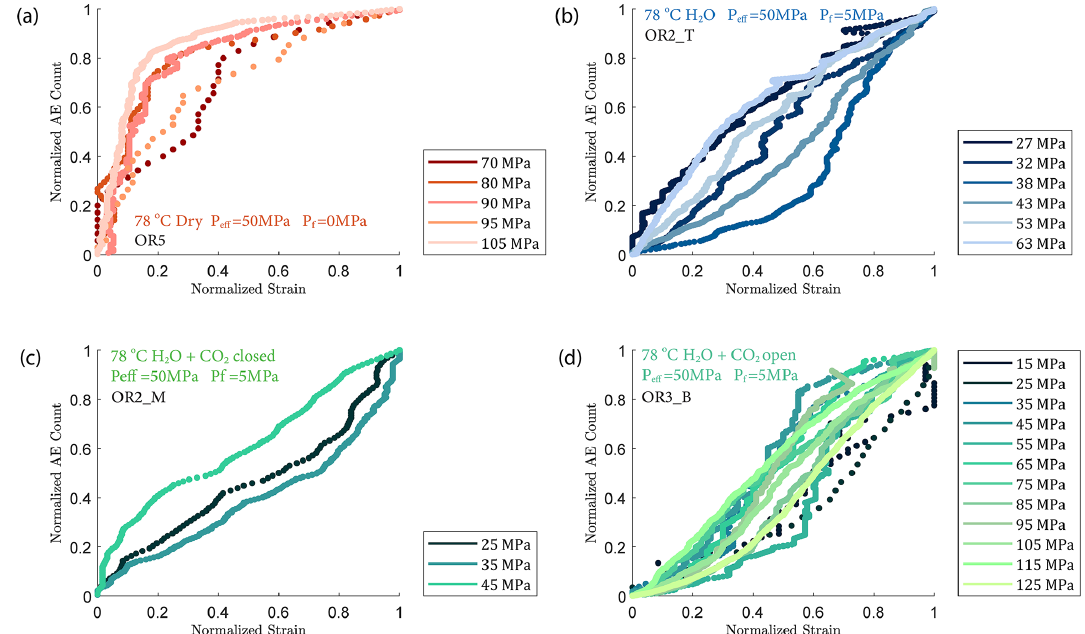
Figure 8. Plot of normalized cumulative AE count vs. strain (a) dry, (b) H 2 O, (c) H 2 O + CO 2 closed and (d) H 2 O + CO 2 open experiments. The normalized cumulative AE counts and strain during each creep step show an approximately linear correlation in most cases, except in the dry experiment.